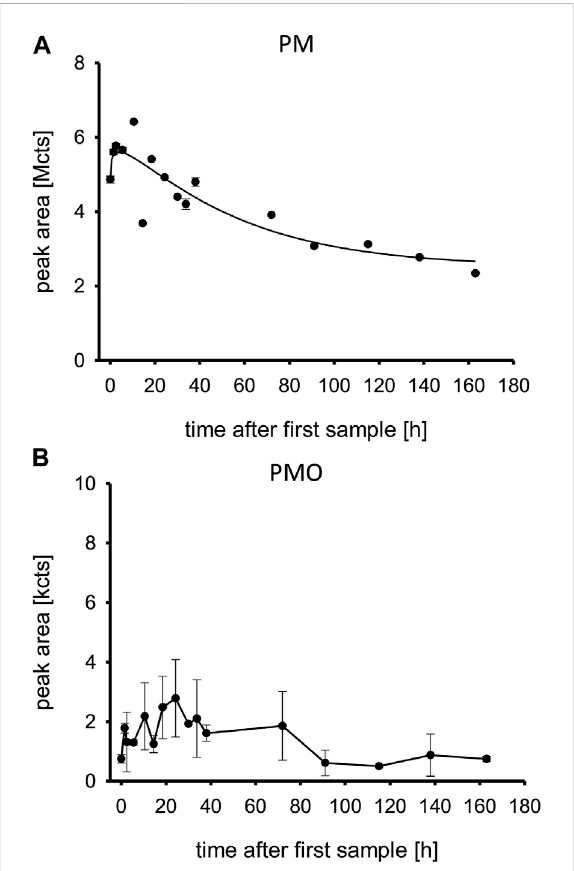
FIGURE 2 (A,B) Pirimiphos-methyl and pirimiphos-methyl-oxon in patient plasma. Time is shown in hours after fi rst blood sample, which was approximately upon admission to the tertiary